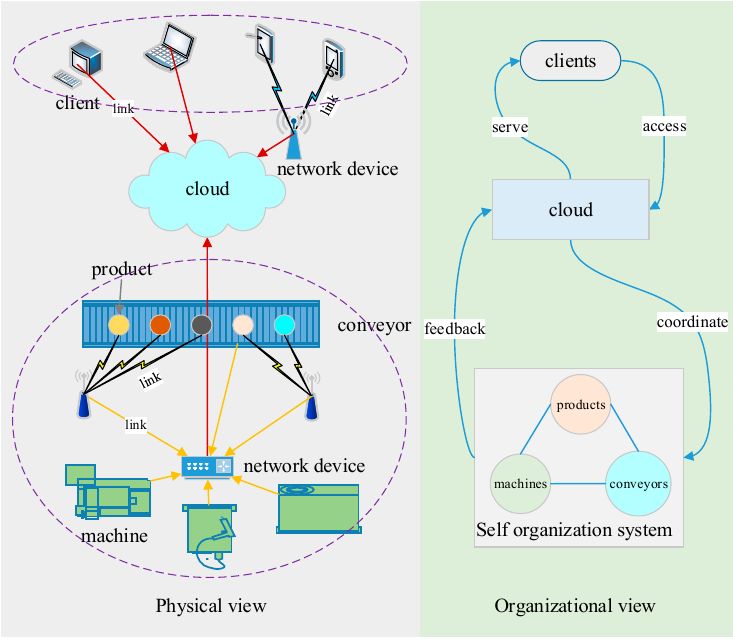
Figure 1. Framework for organizing production-related hardware components of a smart factory.